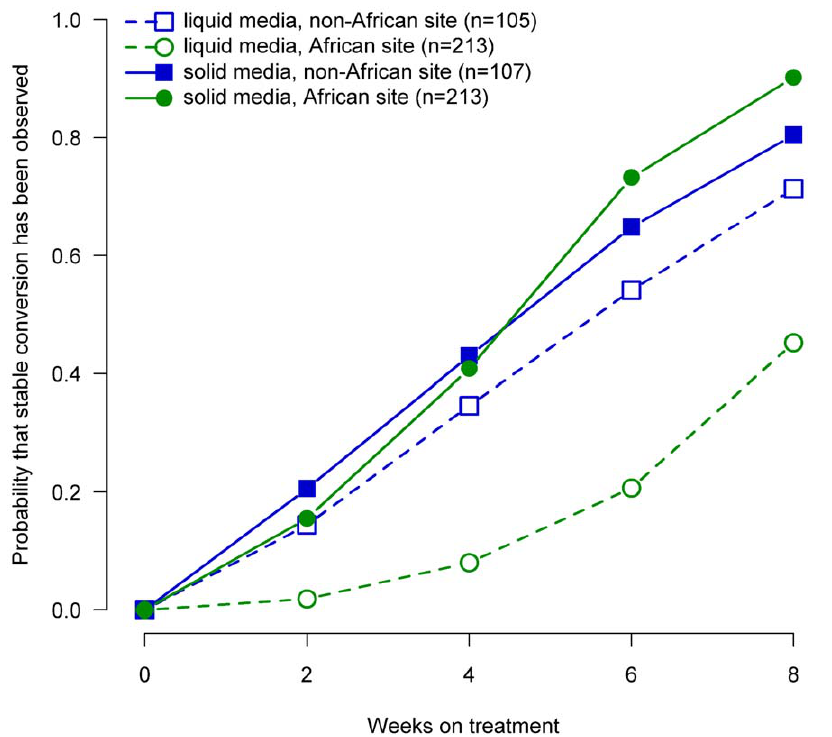
Figure 1. Probability of sputum culture conversion among TBTC Study 28 protocol-correct patients, by week of treatment, region (Africa vs. non-Africa) and culture media type (solid vs. liquid). doi:10.1371/journal.pone.0018358.g001 (Figure 2), cavitary size (Figure 3), radiographic extent of disease (Figure 4) and the number of days to detect growth in liquid media (Figure 5).